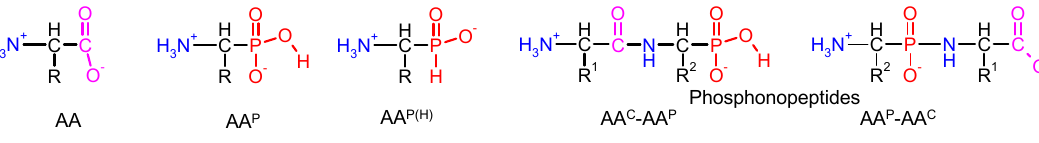
Figure 1. Structures of 1-amino carboxylic acids (AA), 1-aminophosphinic acids (AA P(H) ), 1-aminophosphonic acids (AA P ), phosphonopeptides:P-terminal (AA C -AA P ) and N-terminal (AA P -AA C ) (applied names are in accordance with the general rules elaborated by Kudzin et al. [27,28]). Aminophosphonate compounds of special biological importance are presented in Table 2. Table 2. Aminophosphonate compounds of special biological importance.